Question: Briefly state, in one sentence, what is plotted here.
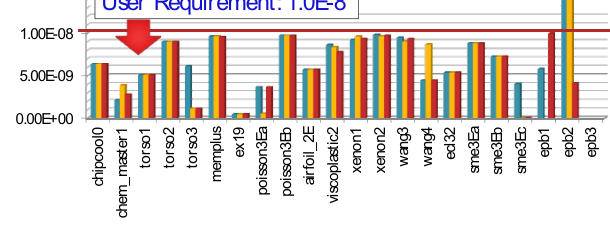
Answer: Effect of the AT for OpenATI_EIGENSOLVE  (Arnoldi) from the Viewpoint of Accuracy. The Y-axis  Shows the Maximum 2-norm for Residual Vectors  of the Standard Eigenproblem.